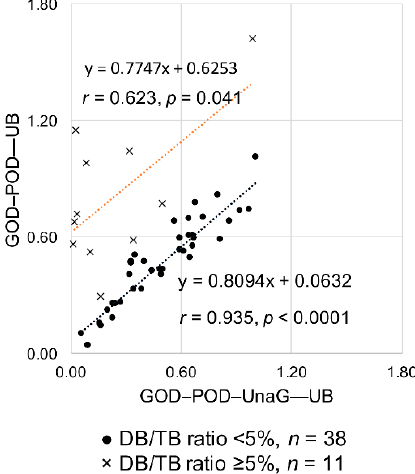
Figure 4. Correlation analysis of UB values determined from the GOD–POD and GOD–POD–UnaG methods. DB, direct bilirubin; GOD, glucose oxidase; POD, peroxidase; TB, total serum bilirubin; UB, unbound bilirubin; UnaG, bilirubin-inducible fluorescent protein from eel muscle.